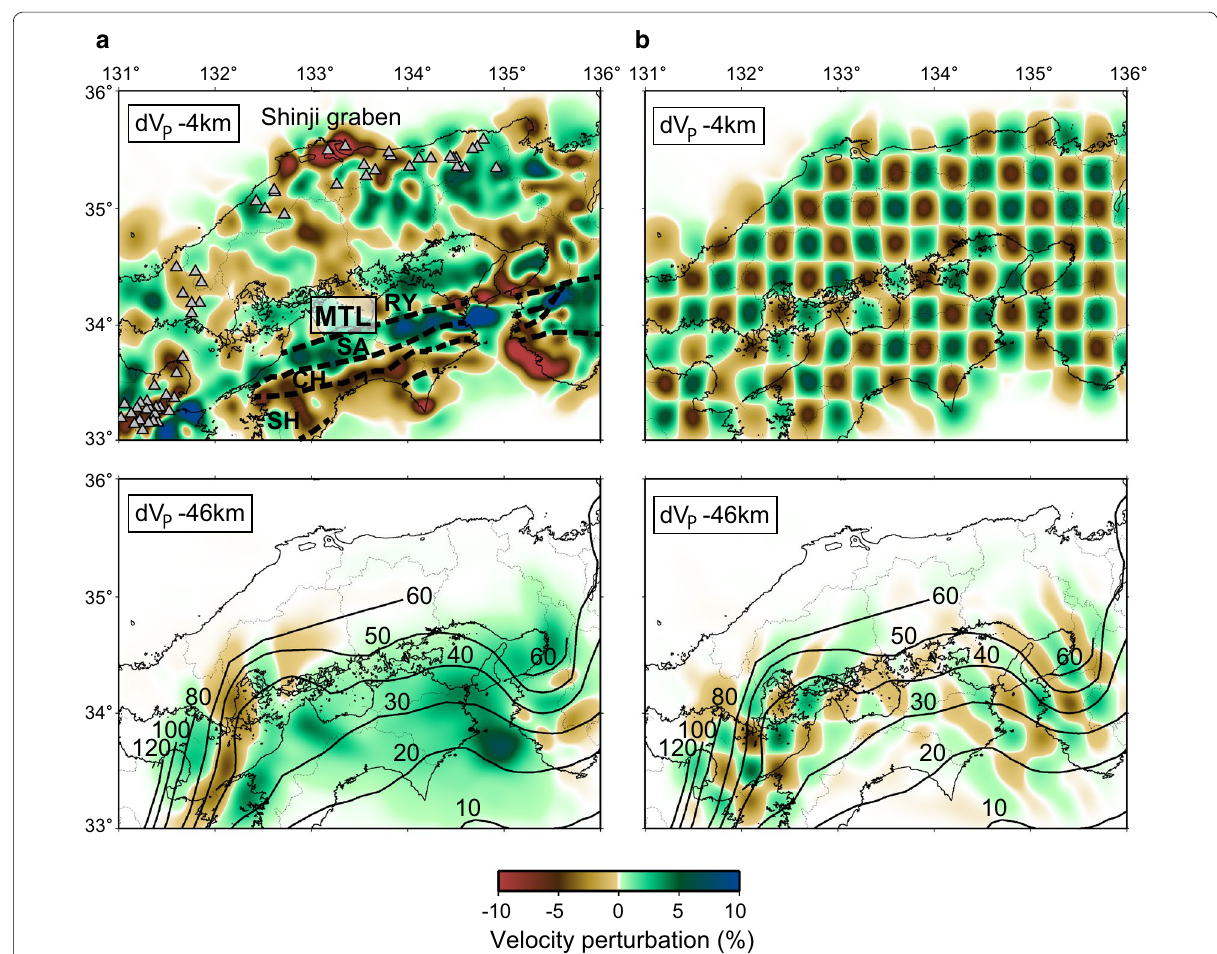
Fig. 3 a P-wave velocity perturbations at depths of 4 and 46 km. b Results of checkerboard resolution tests at those depths. Velocity perturbations are deviations from the initial velocities at each depth. In the upper panel of a , gray triangles denote quaternary volcanoes (Geological Survey of Japan, AIST 2013), and broken lines represent boundaries of geological structures around the MTL (Kodaira et al. 2002). RY, SA, CH, and SH represent the Ryoke belt, Sanbagawa belt, Chichibu belt, and Shimanto belt, respectively. Thick lines in the lower figures represent the isodepth contours of the PHS plate (Baba et al. 2002; Hirose et al. 2008; Nakajima and Hasegawa